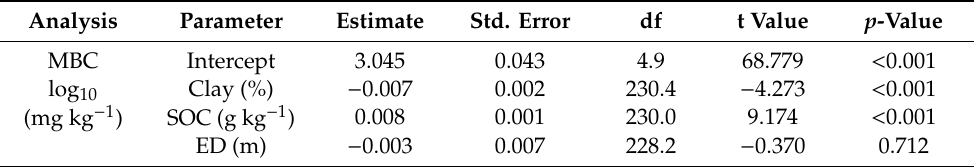
Figure 4. Response of microbial biomass carbon to clay content. See Table 2 for additional information. Table 2. Results of linear mixed e ff ects model looking at the relation of microbial biomass carbon MBC to soil organic carbon (SOC), clay content, and elevation di ff erential